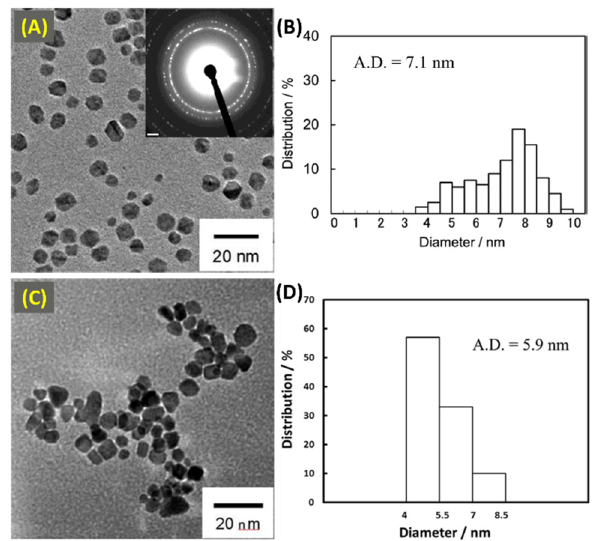
Figure 26. ( A ) HRTEM image with the electron diffraction pattern (inset) and ( B ) size analysis for Pd/Pt (1:1) synthesized using single-mode batch type µwH method and using single-mode flow type µwH method ( C , D ) in EG solvent. Adapted with permission from the American Chemical Society. Copyright 2018 American Chemical Society.